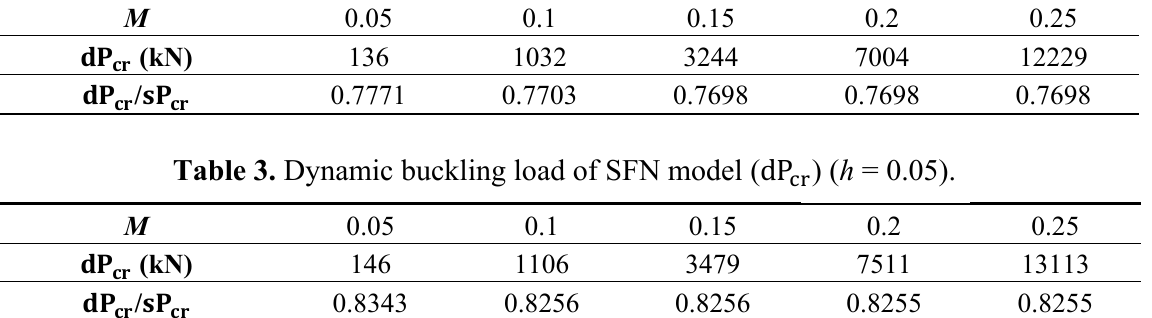
Table 2. Dynamic buckling load of SFN model ( dP